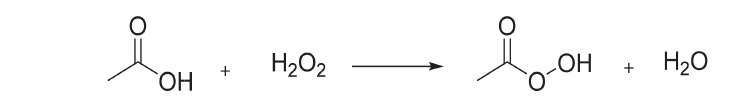
Scheme 1. Formation of peracetic